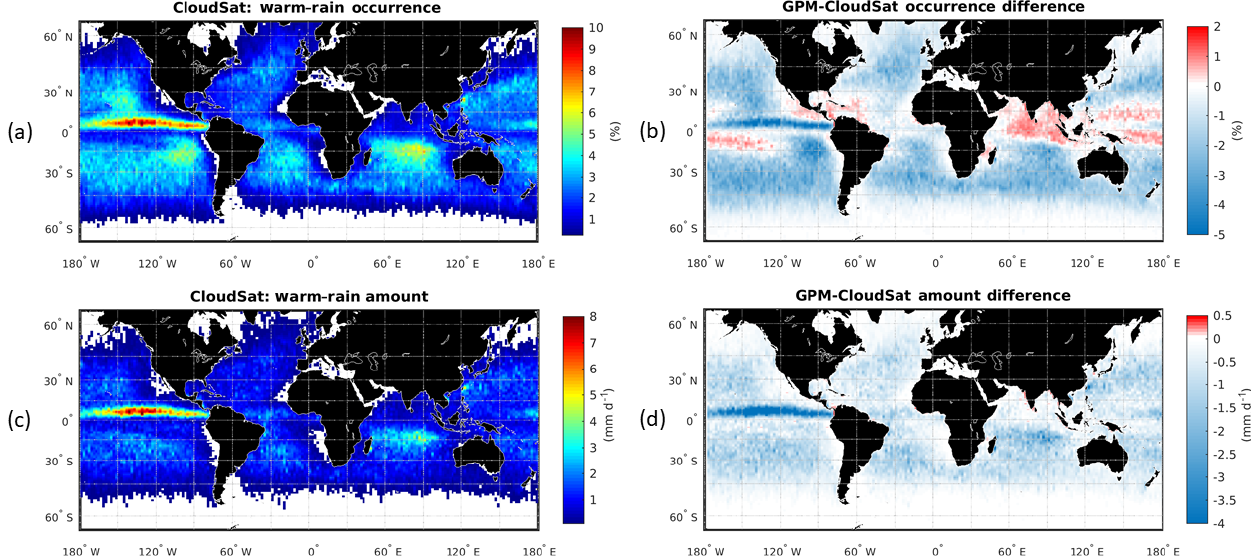
Figure 1. Occurrence and amount of global warm rain at the ground as determined by CloudSat (data from January 2007 to December 2010) and GPM (data from July 2014 to June 2018), using a spatial resolution of 2 ◦ × 2 ◦ . The CloudSat (GPM) results were produced using the 2C-PRECIP-COLUMN and 2C-RAIN-PROFILE (2A-DPR) products. (a, c) Global occurrence and amount of warm rain as observed by CloudSat. (b, d) Difference in occurrence and amount between GPM and CloudSat.